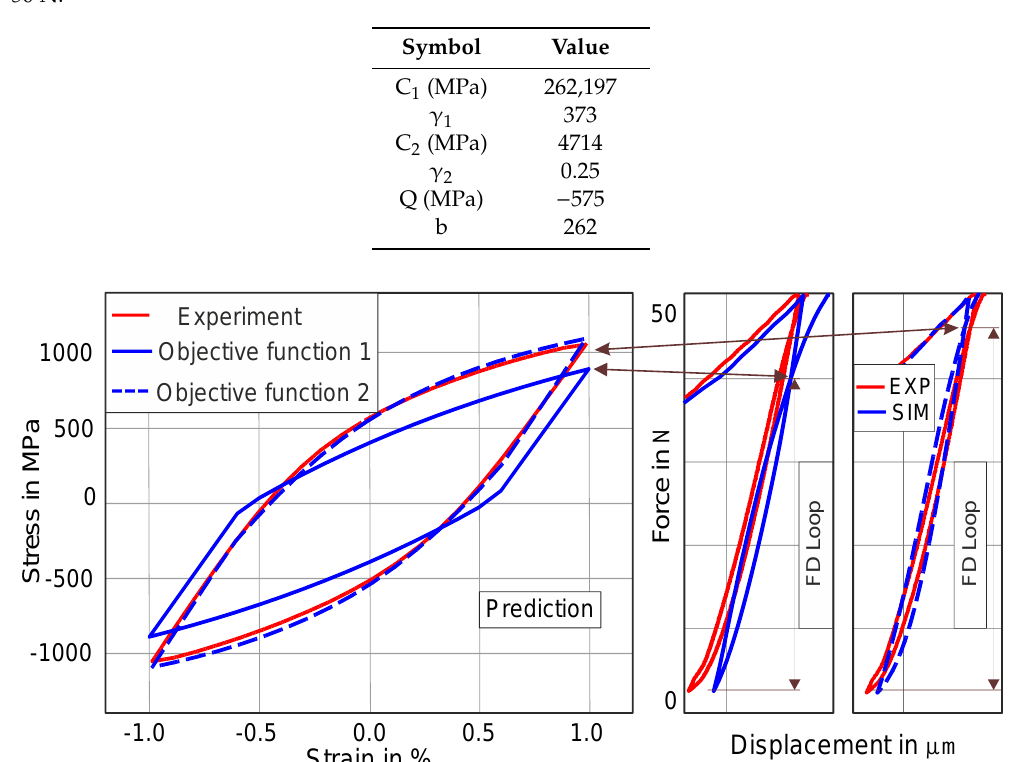
Figure 7. Effect of ∆ F on the uniaxial stress–strain hysteresis prediction. The solid blue force-displacement (FD) loop displays the fitting of the FD loop to the blue experimental FD loop by using objective function 1, while the dotted solid stress–strain hysteresis is the prediction of stress–strain hysteresis. Similarly, the dotted blue FD loop shows the fitting of the FD loop by using objective function 2, while the dotted blue stress–strain hysteresis represents the prediction of the stress–strain hysteresis.